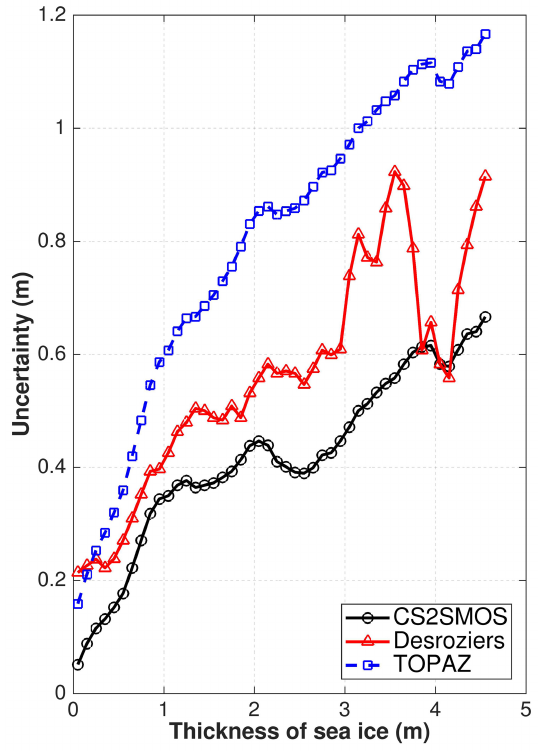
Figure 2. Observation error uncertainties as a function of sea-ice thickness for the original CS2SMOS data set (black line), the esti- mated observation error using the Desroziers diagnostics with red- triangle line (see Eq. 3) and the one used in the TOPAZ Test run with blue-square, with an additional error term as Eq. (4) to the original